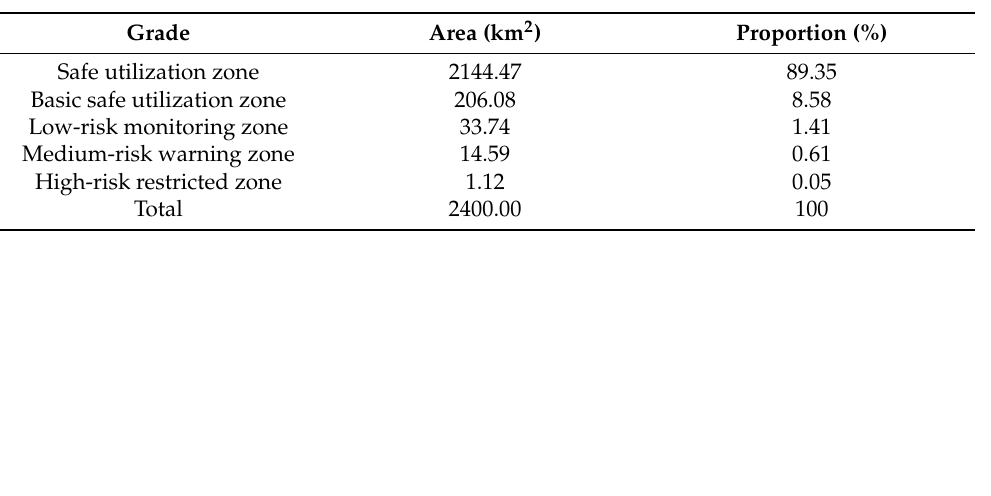
Table 4. Area statistics of each utilization area of farmland soil of Jinhua